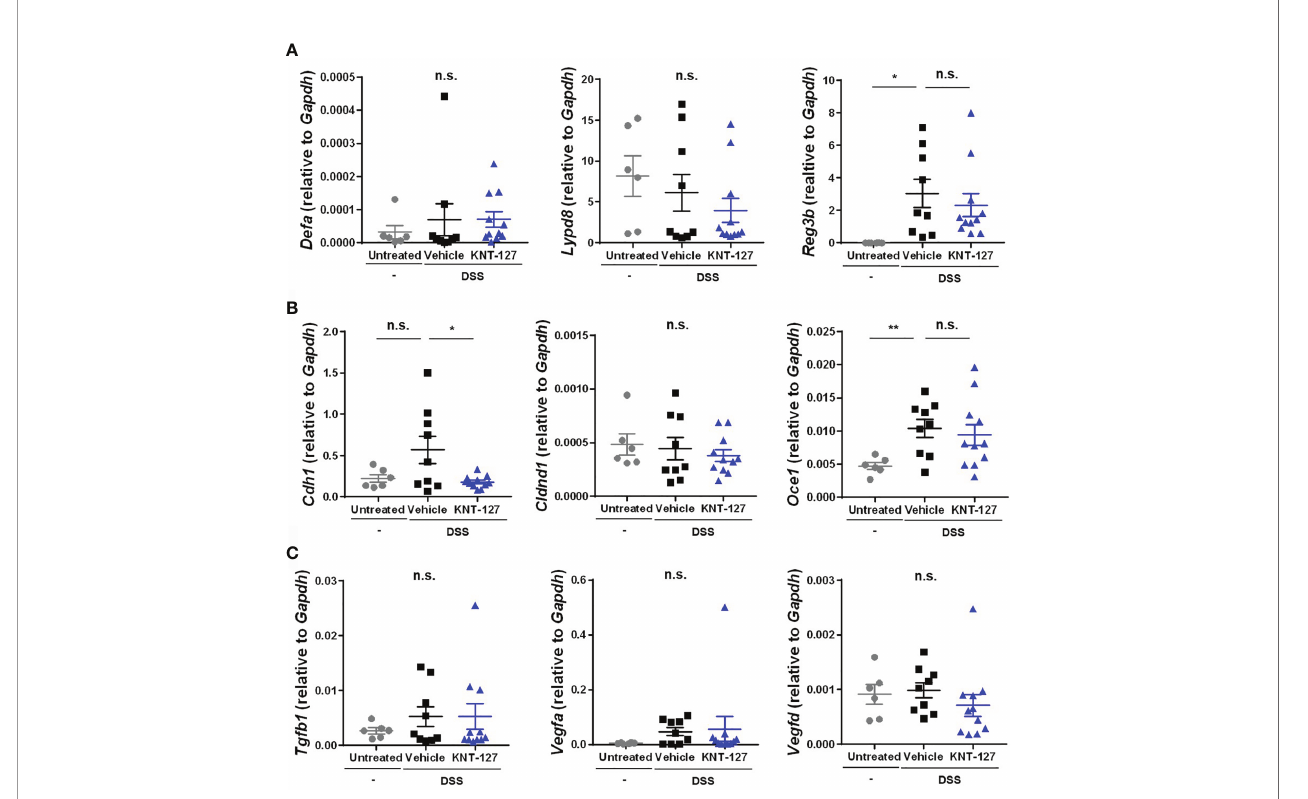
FIGURE 3 | Changes in the intestinal factors. The colon was collected from colitis mice. The mRNA expression of each gene of interest was normalized to that of GAPDH by calculation of the cycle threshold values. (A) mRNA levels of antimicrobial peptides. (B) mRNA levels of tight junction proteins. (C) mRNA levels of growth factors. The data are shown as the mean ± s.e.m. * P < 0.05; ** P < 0.01; n.s., not signi fi cant (one-way ANOVA followed by Dunnett ’ s multiple comparisons test, vs